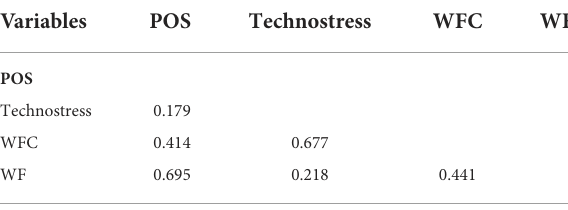
TABLE 2 Quality criteria. TABLE 3 Heterotrait-monotrait ratio discriminant